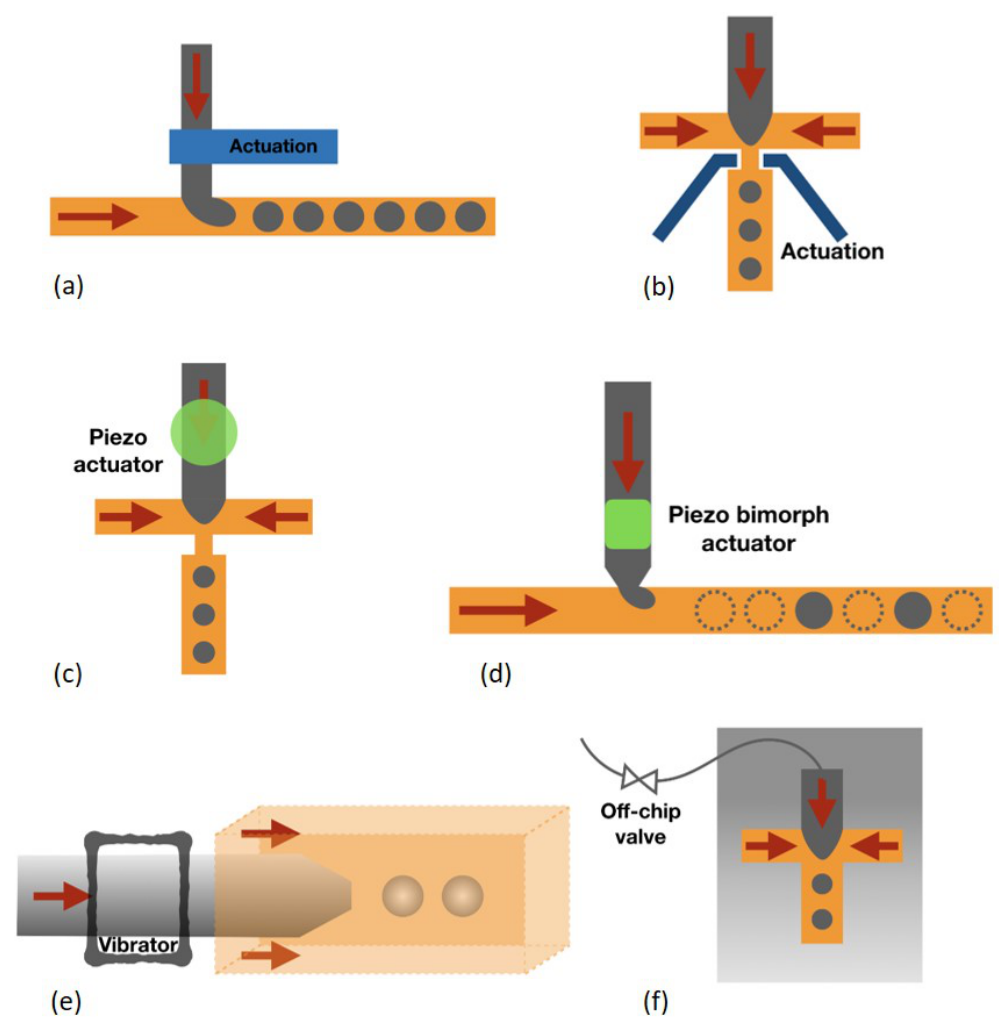
Figure 4. Pneumatic control methods: ( a ) One-side actuation channel. ( b ) Two-side actuation channels. Piezo actuation: ( c ) Piezoelectric disc under the dispersed phase. ( d ) Piezo bimorph actuator for on-demand droplet generation. Off-chip vibration: ( e ) A mechanical vibrator vibrates the microtubing. ( f ) Off-chip valves control dispersed phase